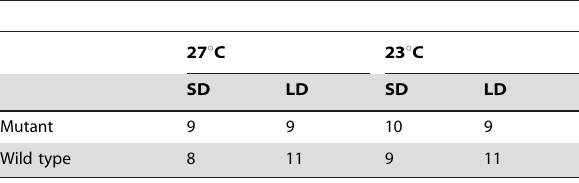
Table 2. Leaf number of mutant and wild type in different photoperiod treatments and temperature